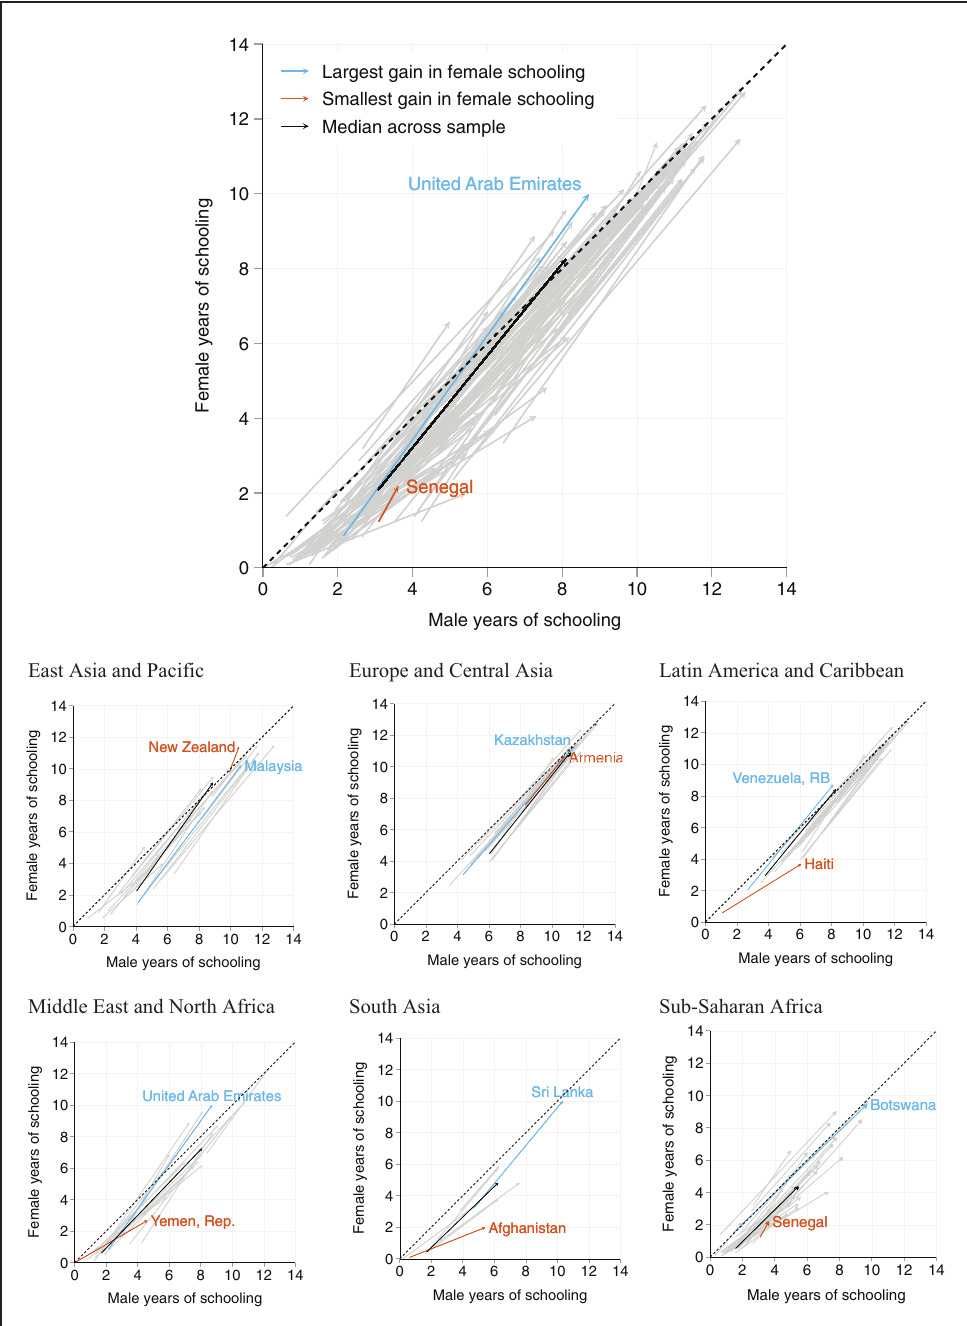
Figure 1 Change in Average Schooling Years Between 1960 and